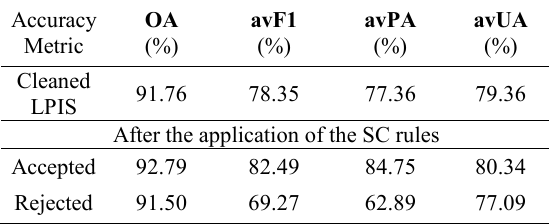
Table 4. Overall accuracy (OA) and average rates of F1 score